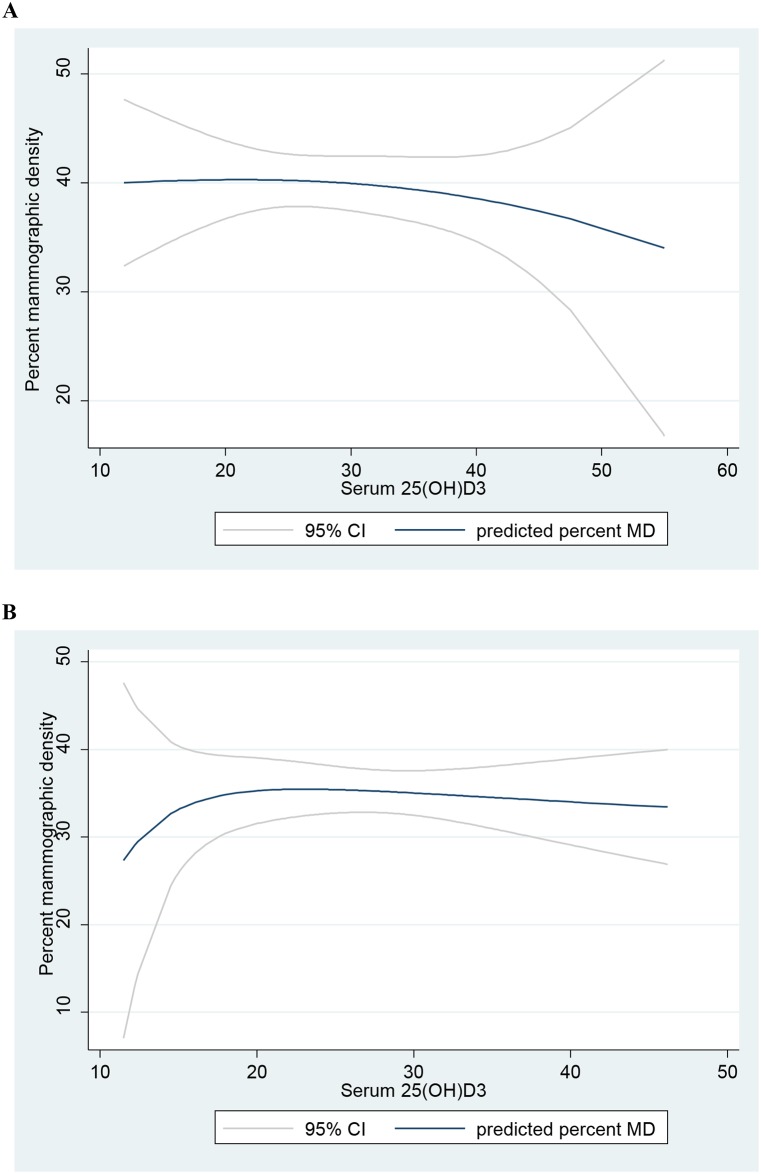
Fractional polynomial modelling of the association of serum 25(OH)D3 (ng/ml) with percent mammography density (MD).A model with 95%CI among women with: A) BMI < median (< 27.4 kgm2), B) BMI ≥ median (≥ 27.4 kgm2).